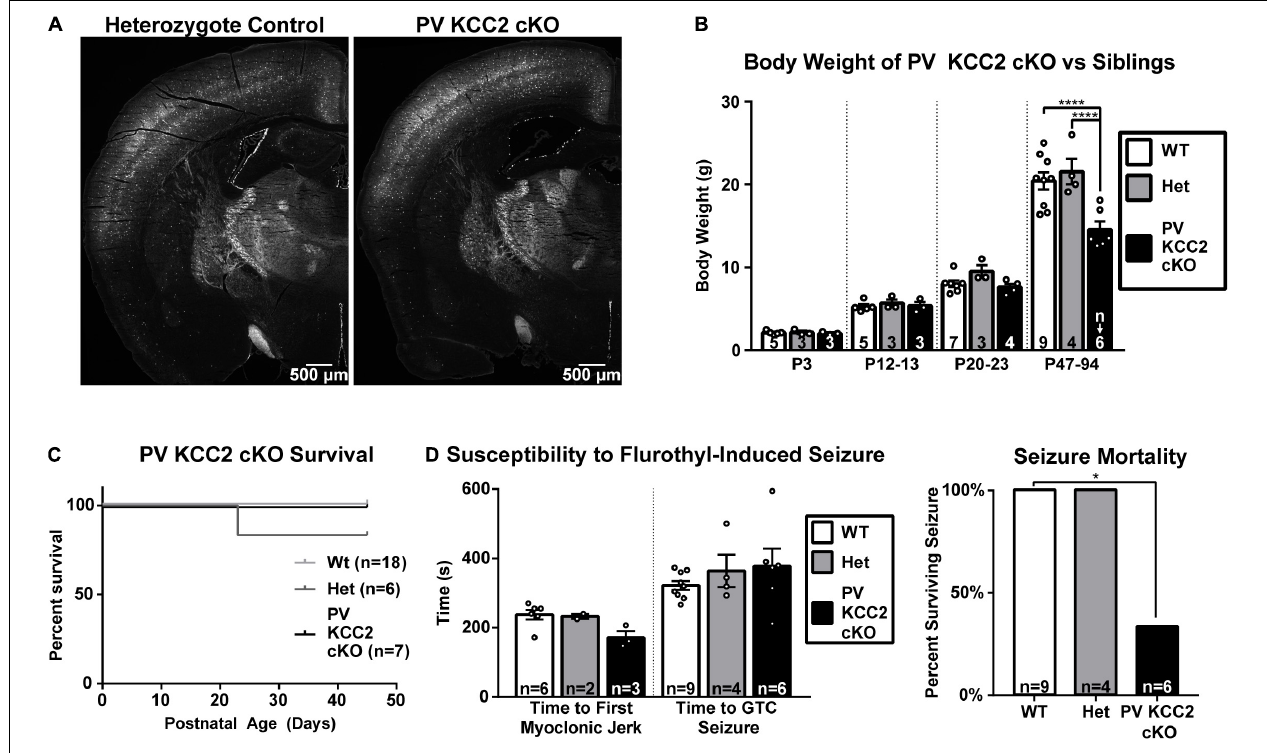
FIGURE 8 | Selective loss of KCC2 in parvalbumin neurons does not cause seizure susceptibility nor failure to thrive. (A) PV INs labeled by Ai14 cre reporter in hemisections of P64 PV KCC2 cKO and sibling control. (B) Body weight of PV KCC2 cKO. One-way ANOVA with Sidak’s multiple comparisons: **** P < 0.0001. Note normal PV KCC2 cKO body weight until adulthood, when it is slightly diminished. (C) Postnatal survival is unaffected in PV KCC2 cKO. (D) Seizure susceptibility (right) measured by time to first myoclonic jerk and generalized tonic clonic seizure (left) and seizure mortality (right) resulting from flurothyl seizure induction in PV KCC2 cKO mice. Note that PV KCC2 cKO do not exhibit faster onset of induced seizures, but are highly likely to die from them. Chi squared with Yates’ correction: * P < 0.05. The number of mice examined is indicated by n values in each panel. For bar graphs, these are listed at the bottom of each